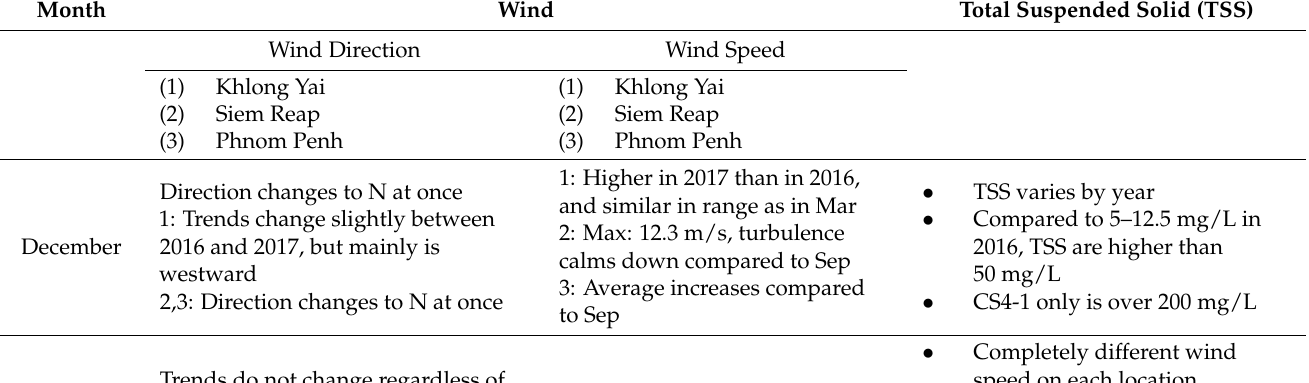
Table 2. Comparison of the wind and TSS at (1) Khlong Yai, (2) Siem Reap, and (3) Phnom Penh.